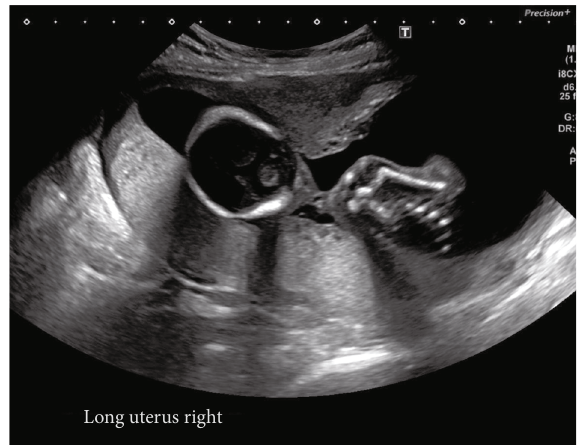
Figure 3: This transabdominal ultrasound image shows a right parasagittal plane at 18 weeks of gestation during the fi rst pregnancy. A posterior placenta can be seen. Part of the uterus which appears to be a portion of the septum is seen anteriorly abutting the fetal